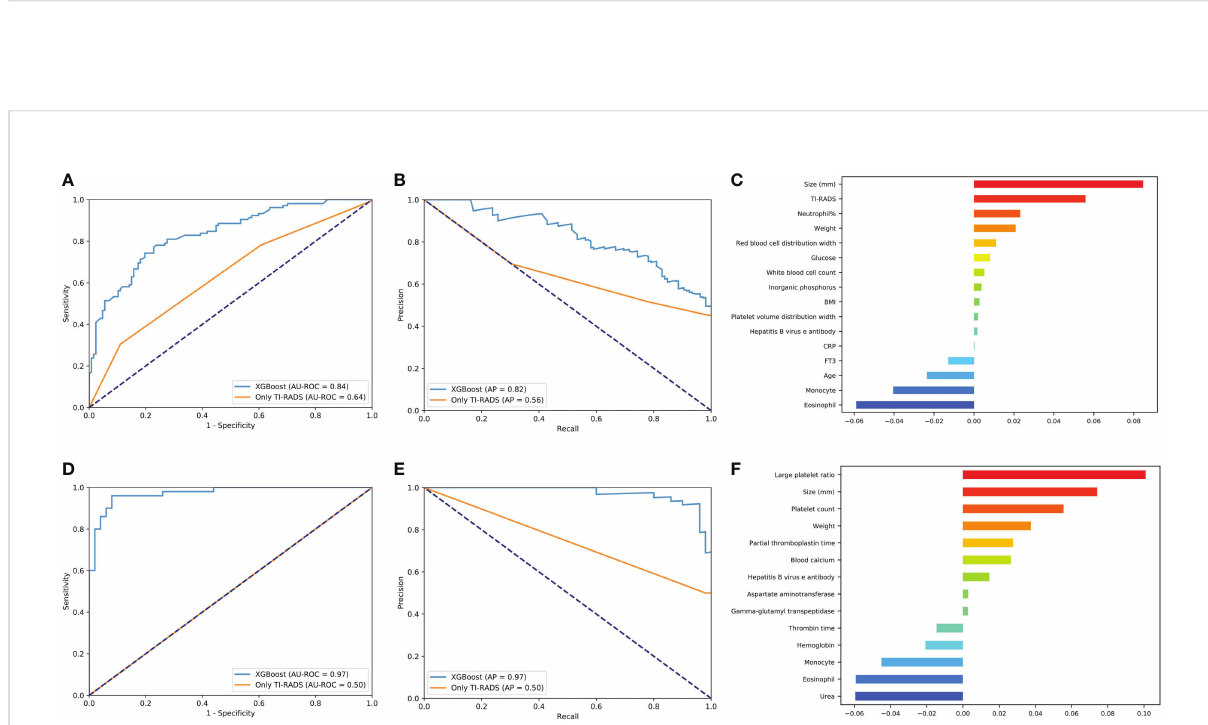
FIGURE 5 Predictive models of metastasis evaluation for benign/malignant nodules of all 4 th category of TI-RADS and only 4th category . (A, D) The average ROC curves from of XGBoost and Only TI-RADS models in the validation sets. (B, E) The average PR curves, indicating the tradeoff between precision and recall. (C, F) The histogram describes the important features of the XGBoost predictive model for metastasis in all 4 th category of TI-RADS and only 4th